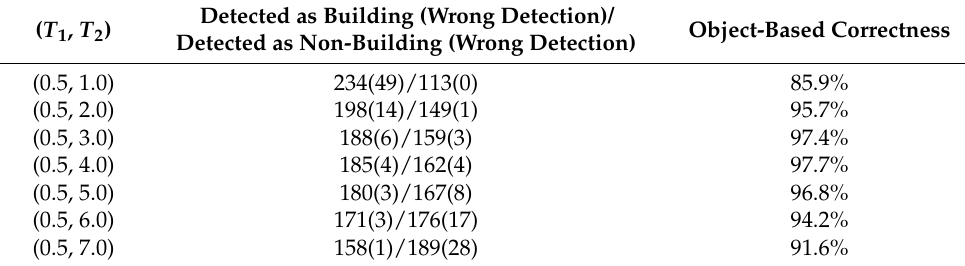
Table 7. Statistics of the object-based classification with different T 2